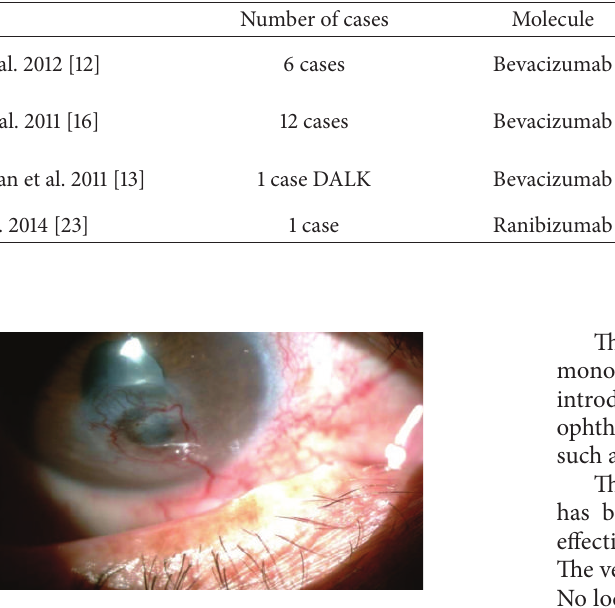
in 2 patients after an average of five months. No cases of hypertension or systemic complications were